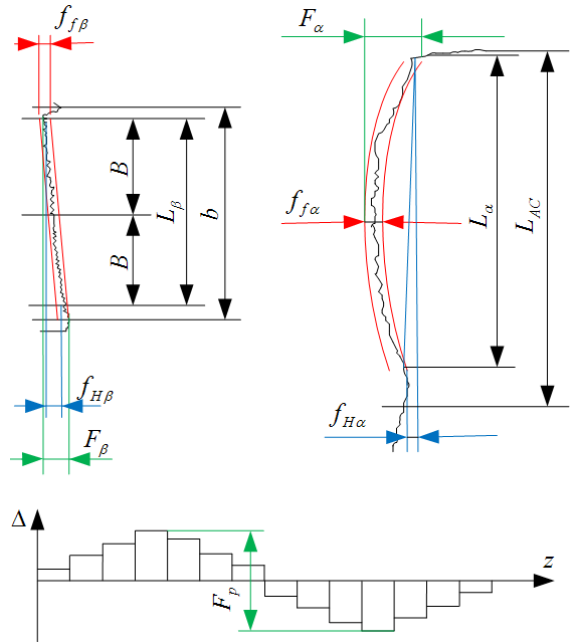
Figure 1. Diagrams of gear profile